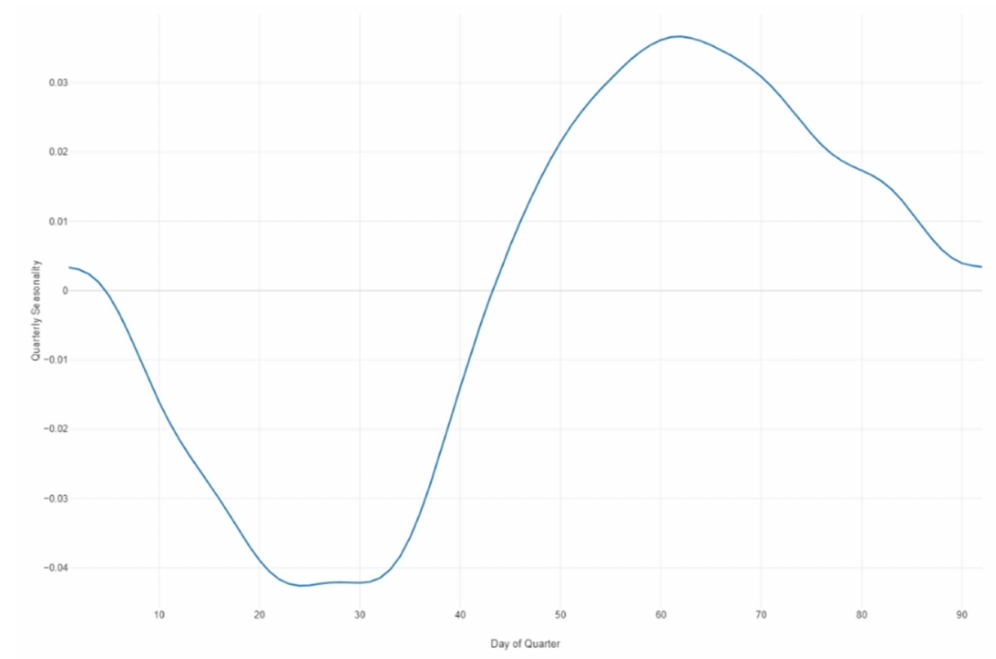
Figure 33. Prophet forecast quarterly